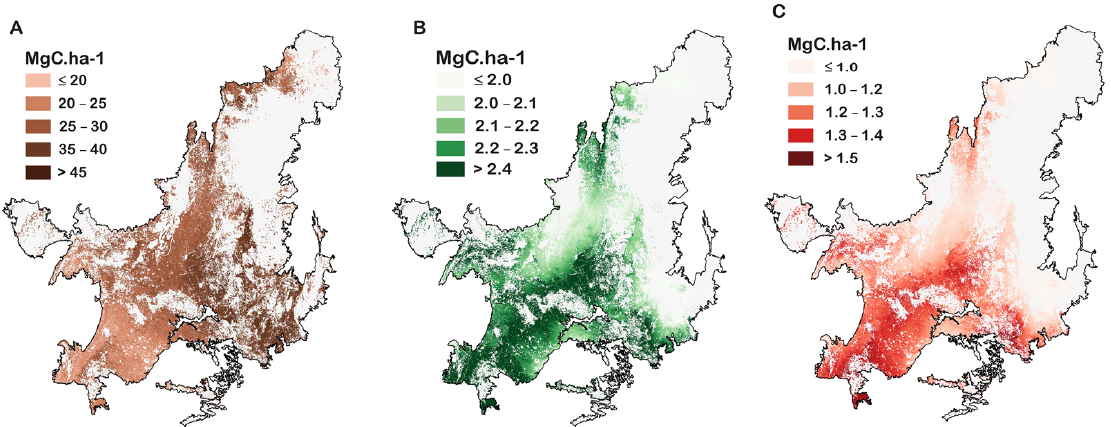
Figure 4. Estimated carbon stock for pasture areas of the Cerrado biome in the year 2019. ( A ) Carbon in soil organic matter. ( B ) Carbon in living aboveground biomass. ( C ) Standing dead carbon in aboveground biomass.